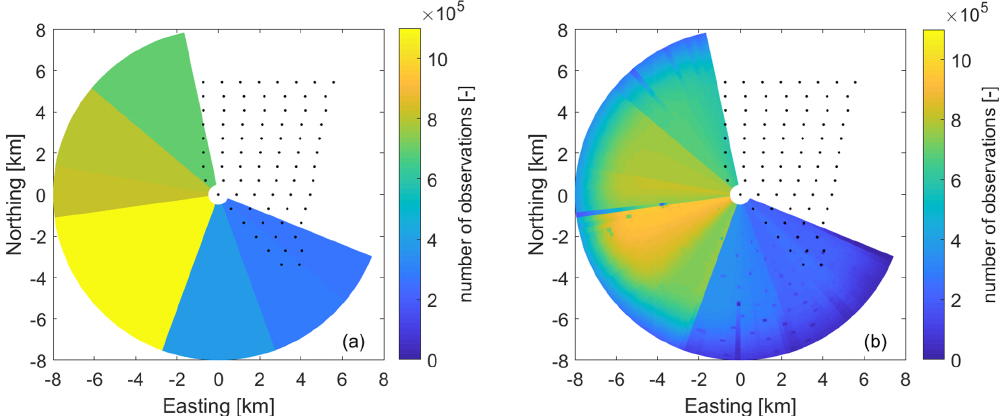
Figure 8. Distribution of measurements across the measurement domain as a result of varying lidar trajectories. The number of observations at each measurement point in the polar coordinate system of the lidar is visualized (a) before and (b) after data filtering. Filtering includes the density filter, the exclusion of critical regions and filtering of wind speed outliers.